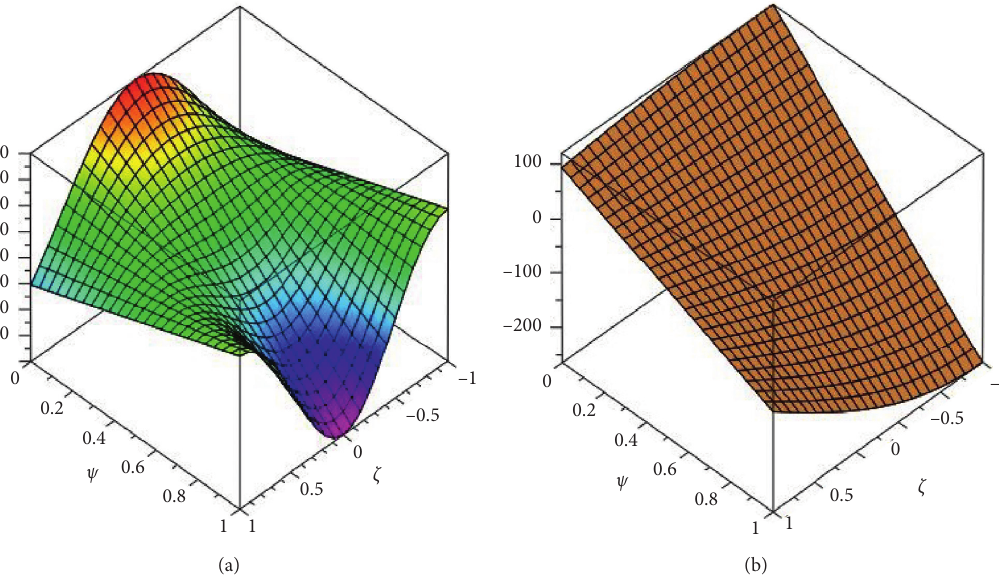
Figure 1: HPTM solutions of μ ( ζ , Ψ ) and ρ ( ζ , Ψ ) at c � 1.